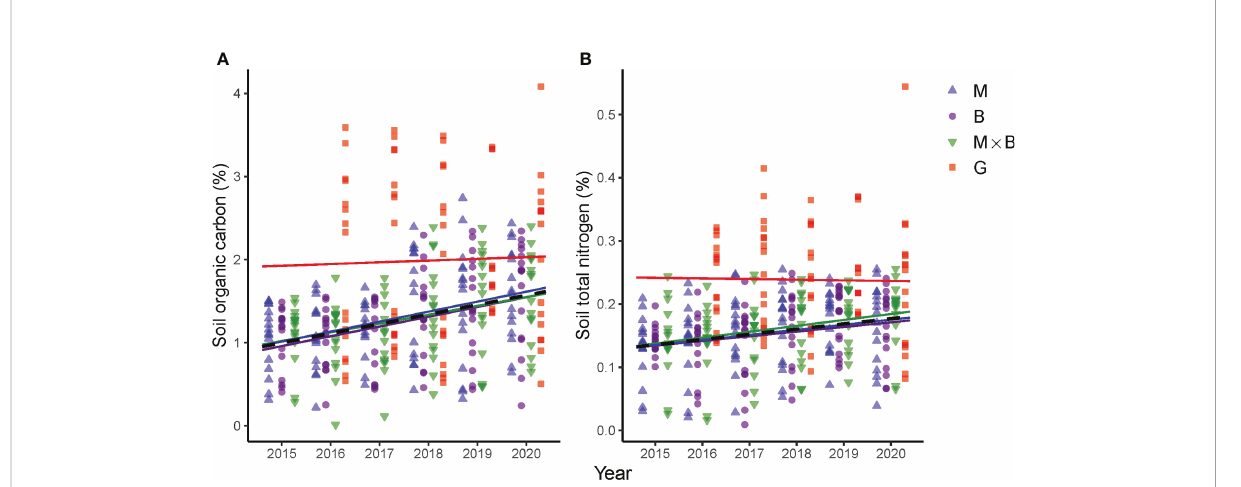
FIGURE 8 Temporal variations and trends in soil organic carbon (A) and soil total nitrogen (B) contents at the depth range of 0-60 cm under the alfalfa (M), smooth bromegrass (B) monocultures and the M×B mixture as compared to a natural grassland (G) from 2015 to 2020. The year 2015 is included as a baseline which shows pre-experiment C and N levels. Linear trends are fi tted to SOC and TN measurements per treatment, whose color coding is kept in agreement with the